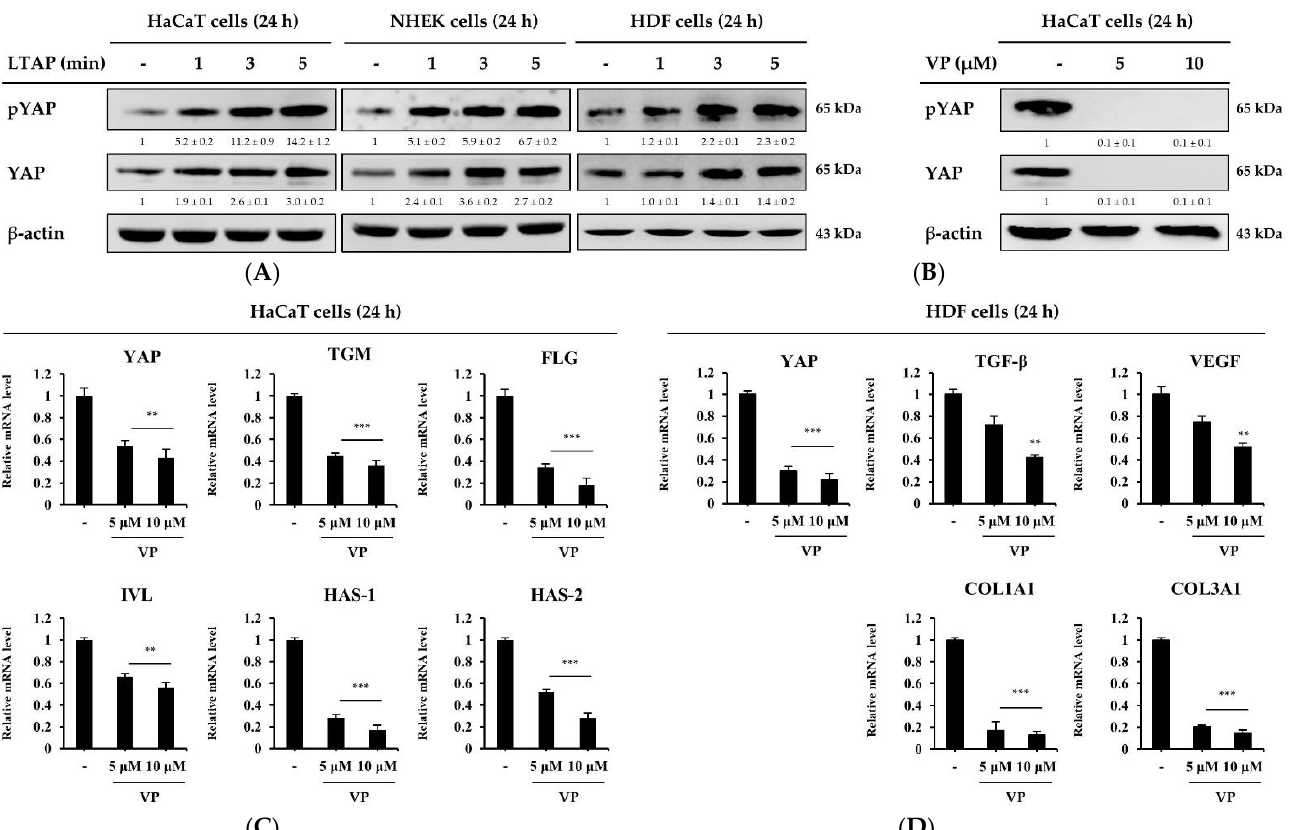
Figure 3. LTAP regulates skin moisturizing and aging factors through yes-associated protein (YAP). ( A ) HaCaT cells, NHEKs, and HDFs were exposed to LTAP for 1, 3, or 5 min, and further incubated for 24 h. Cells were harvested and the levels of phosphorylated YAP (pYAP), and YAP were evaluated by Western blotting. β -actin was used as a loading control. ( B ) HaCaT cells were treated with either 5 or 10 μM verteporin (VP), and further incubated for 24 h. The levels of pYAP and YAP were evaluated by Western blotting. Numerical values on the blots represent DU. The control was normalized to 1 DU. All data represent three independent experiments. ( C ) The expression of YAP , TGM , FLG , IVL and HAS-1 , 2 in HaCaT cells was analyzed by qRT-PCR. ( D ) HDFs were treated with either 5 or 10 μM VP, and further incubated for 24 h. Cells were harvested for mRNA isolation, and expression of YAP , TGF- β , VEGF , COL1A1 and COL3A1 was determined by qRT-PCR. Data represent the mean ± SD. ** p < 0.01, *** p < 0.001. All data represent three independent experiments.